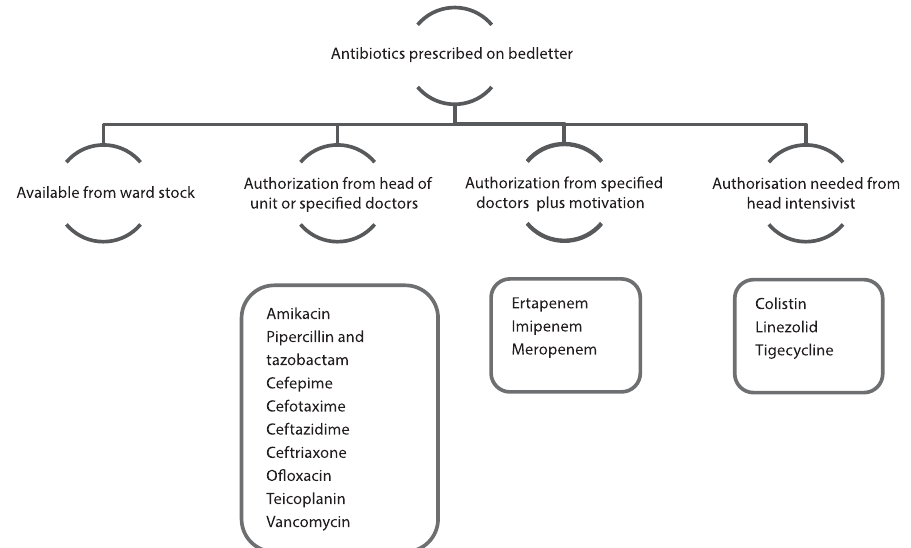
Figure 1: Process followed when ordering